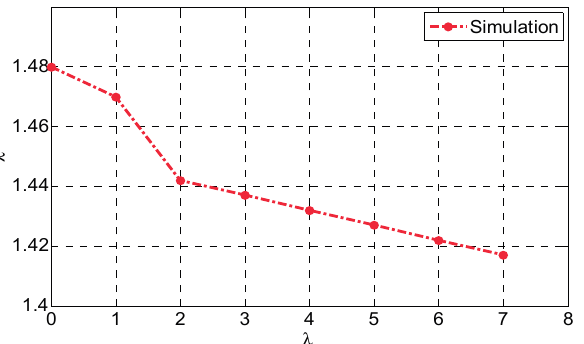
Figure 5. The dynamic simulated results of (cid:2031) vs . (cid:2019) with Pioneer P3-AT robot using parameters in Table